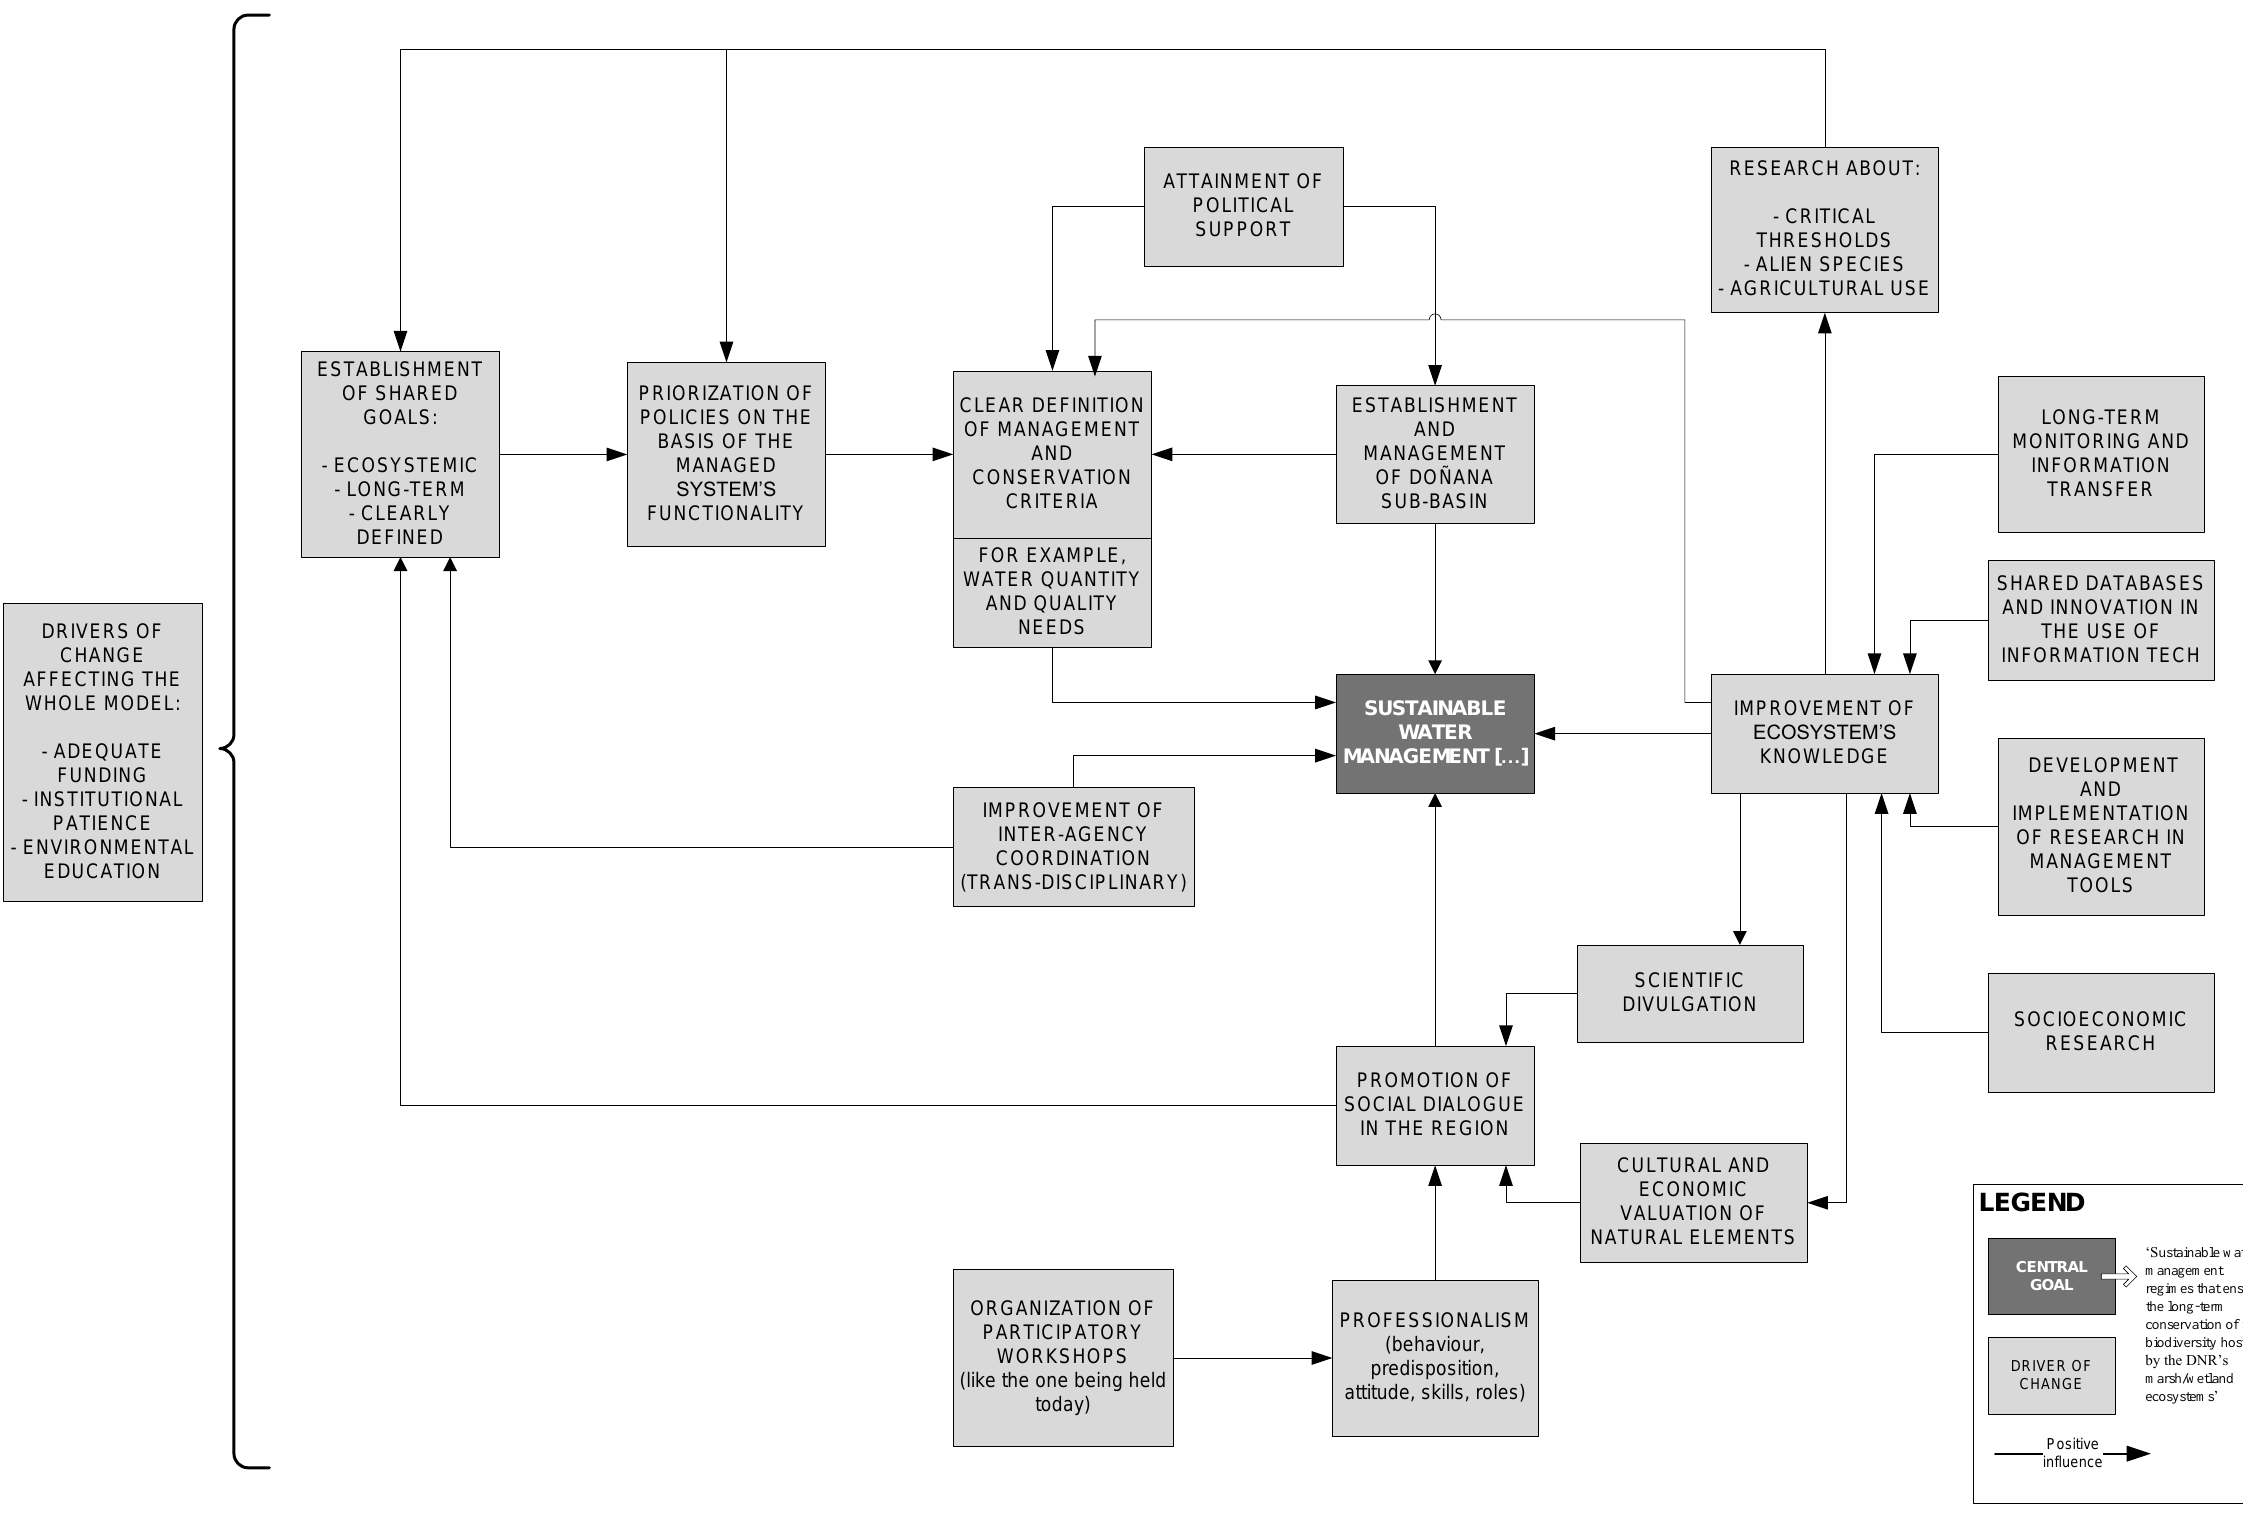
Fig. A2.1. Water-management